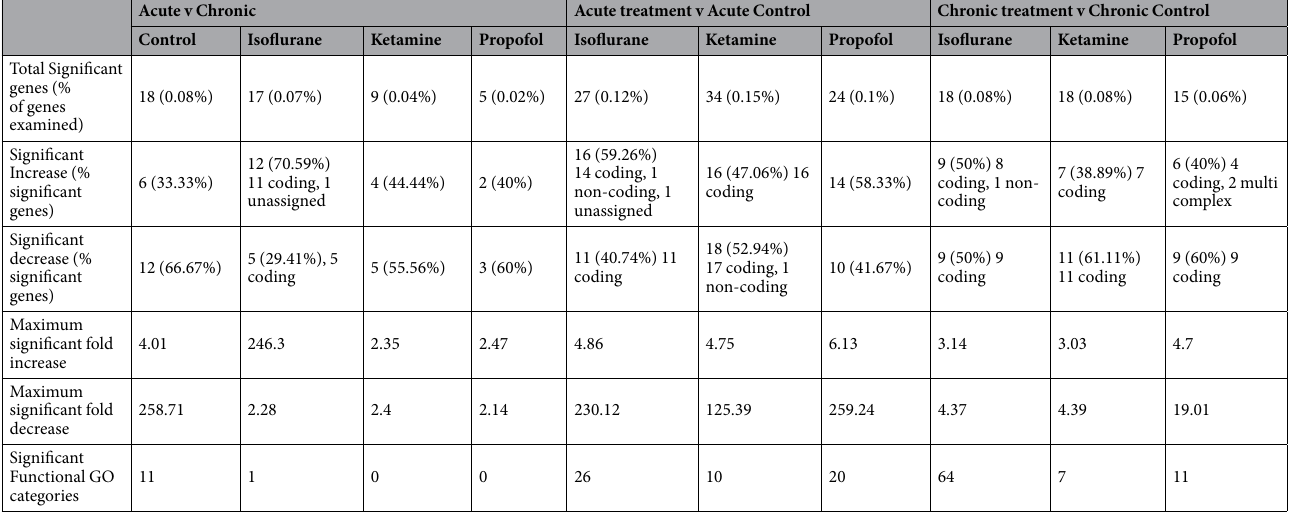
Table 1. Summary of biostatistical and bioinformatic analyses for individual treatments – Acute Control vs Acute treatment and Chronic Control vs Chronic Treatment. GO – gene ontology